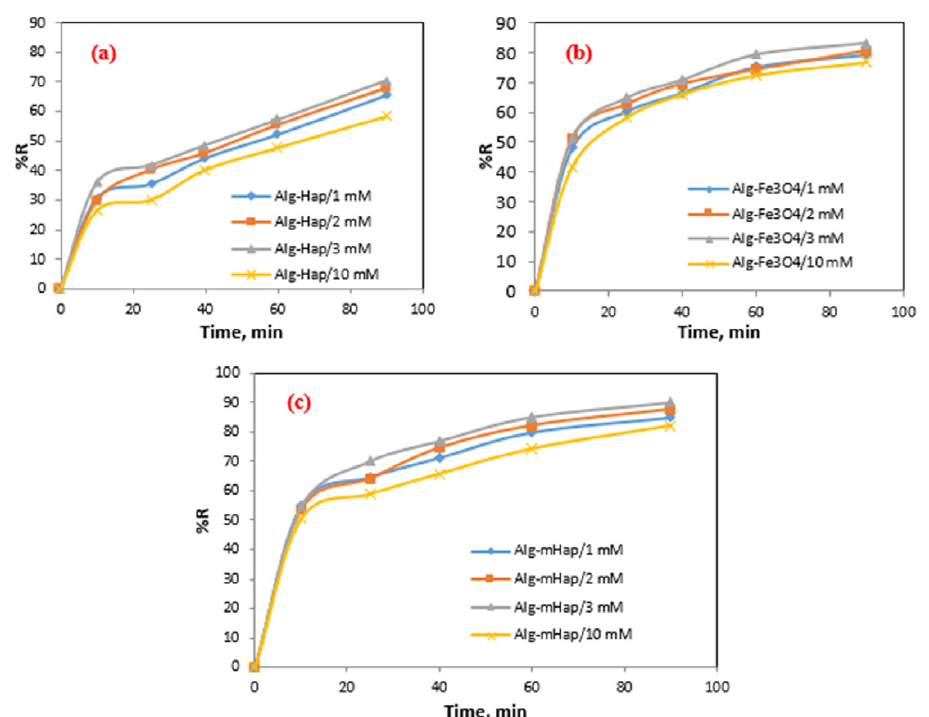
Fig. 9. Effect of hydrogen peroxide concentration on cefixime removal (a) Alg-Hap, (b) Alg-Fe